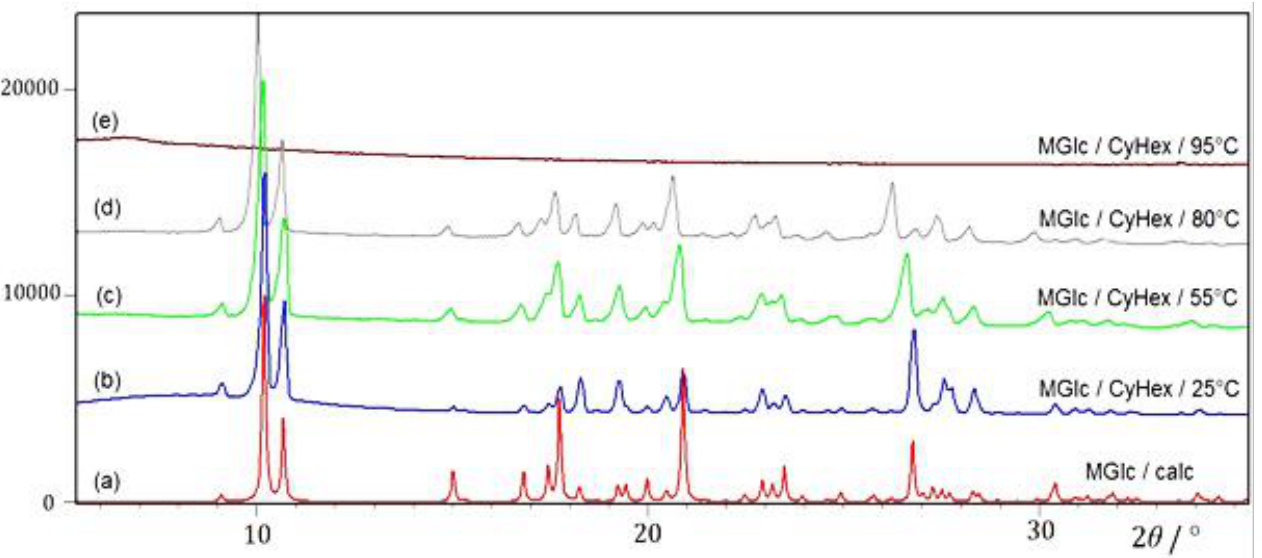
Figure 5. Powder X-ray diffraction patterns of MGlc crystallised from cyclohexane were recorded at 25, 55, 80, and 95° C ( b – e ). The reference pattern of MGlc ( a ) calculated from the single-crystal data is given in red.